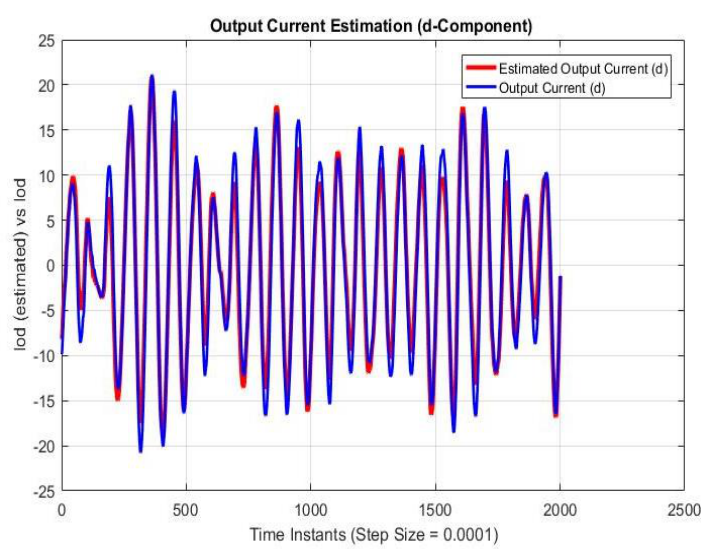
Figure 5. Fault diagnostic observer based output current estimation